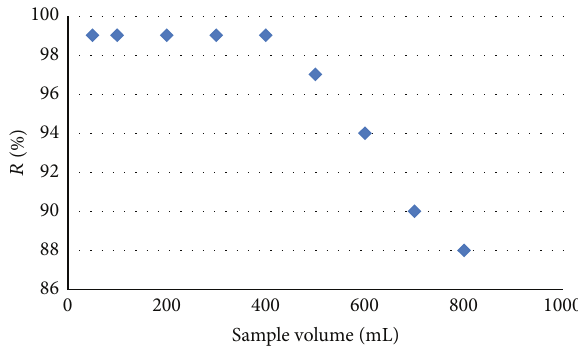
Table 4: Determination of total arsenic in drinking water sample (Taghe Bostan, Kermanshah, Iran) before and after spiking the standard solution of As